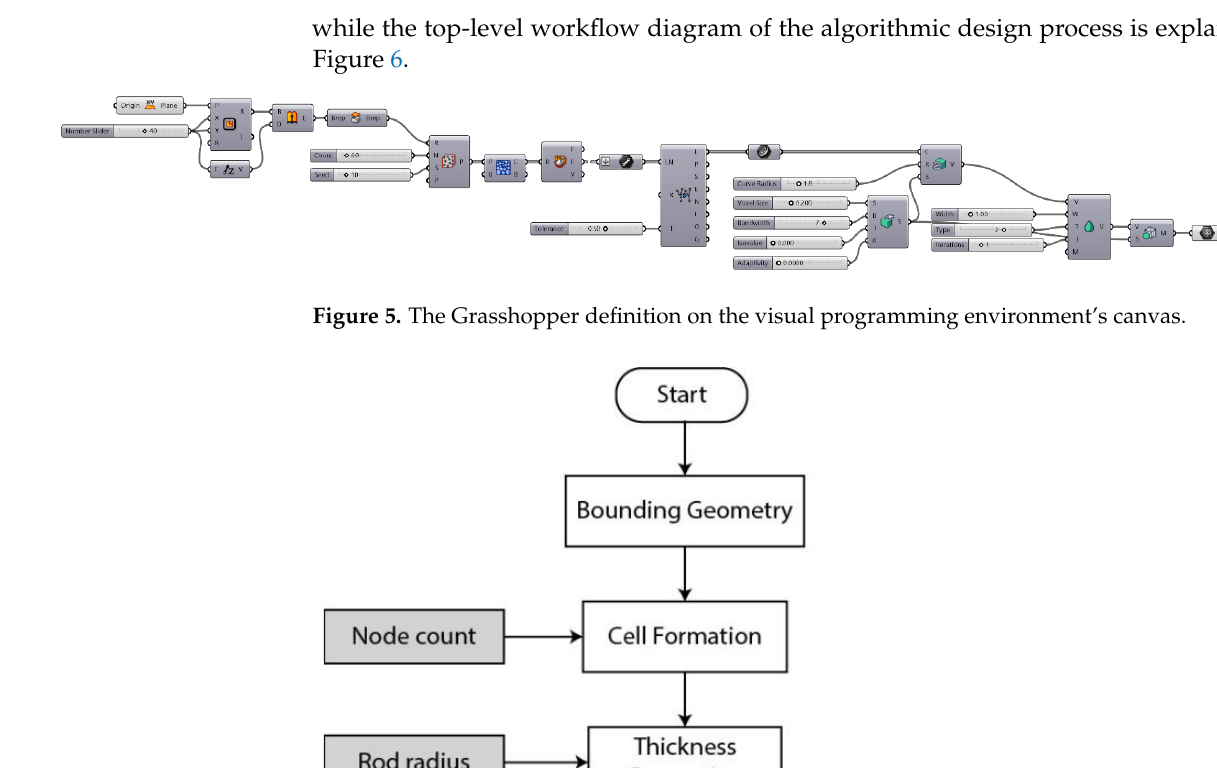
Figure 6. Top-level workflow diagram of the interactive, parametric design process of a biomimetic Voronoi lattice. The most important user-defined parameters are found in the grey boxes.